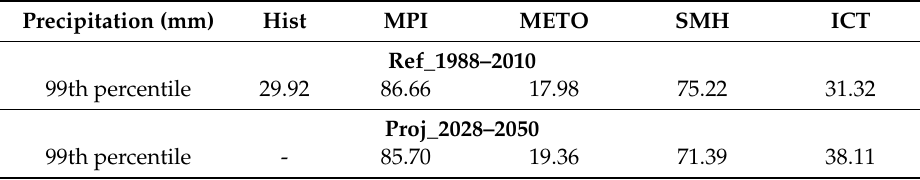
Table 3. 99th percentile values of daily precipitation in the Mono river